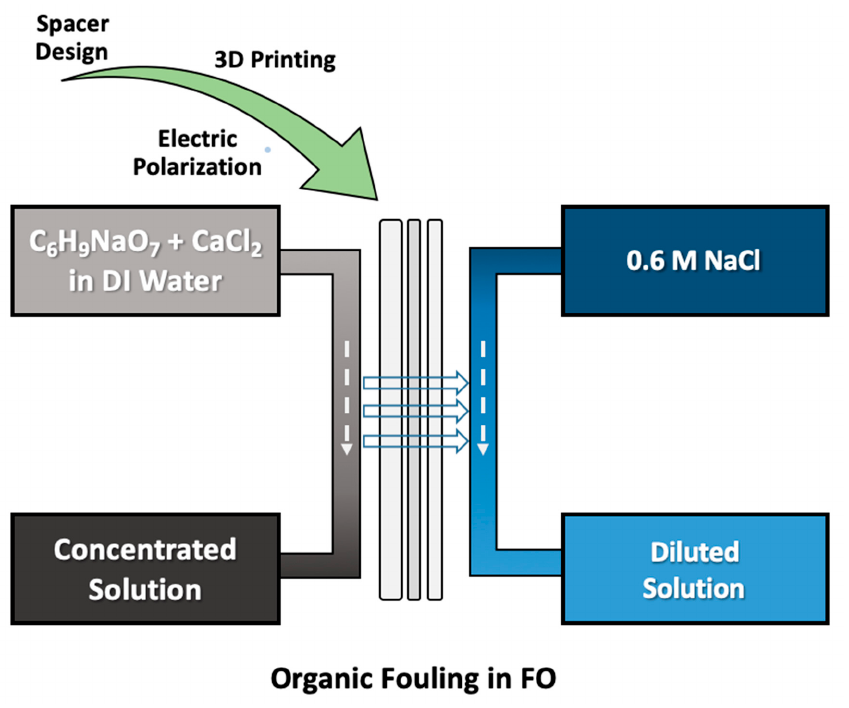
Figure 2. Organic fouling test of 3D printed spacers through a forward osmosis system. Surface roughness of fouled membranes, foulant volume on membranes, and visual topographic images of fouled membranes were obtained by a Surface Nano-Profiler (Nanomap-D/Alpha-steps, HTSK, Gyeonggi, Korea) measurements. 3D measurements were performed with an x – y scanning distance of 500 µm and a scanning speed of 50 µm/s at 10 steps for each sample. These measurements were repeated 10 times for each